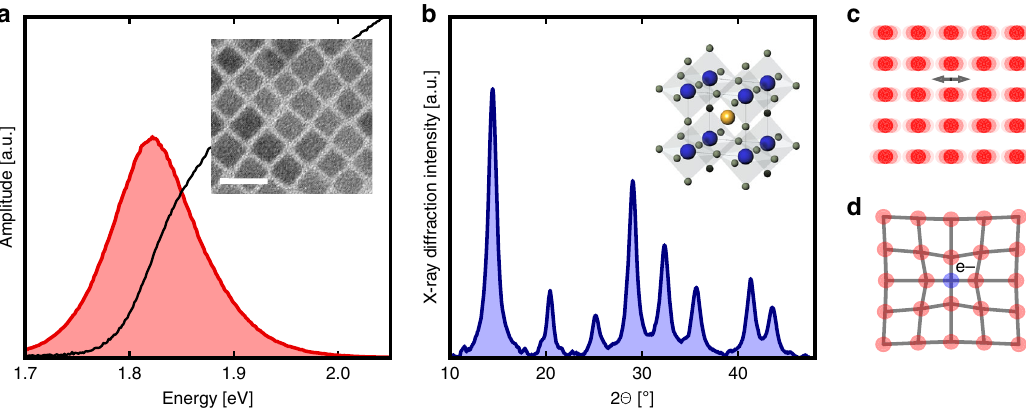
Fig. 1 Static measurements of optical and structural properties of CsPbI 3 nanocrystals. a Linear optical absorption (black) and photoluminescence (red) of the perovskite nanocrystals in solution. Inset: representative transmission electron microscope image of the sample under study. Scale bar: 20nm. b X-ray diffraction data of the nanocrystals (dark blue). c , d Cartoon representations of phonons ( c ) and a polaron ( d )